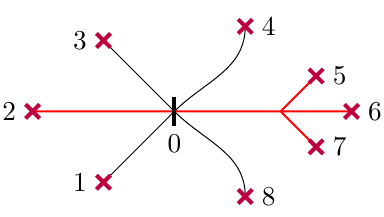
Figure 5 . Schematic example of a spectral network for instanton calculus. Here we have not depicted all the WKB lines, only those that (cid:13)ow to point 0 are shown, they are terminated at 0. We expect that WKB lines starting from branching points 1, 3, 4, 8 do not contribute as they are not symmetric with respect to re(cid:13)ection. WKB lines emanated from 2 and 6 are obviously symmetric with respect to re(cid:13)ection therefore they may contribute. Primary WKB lines emanated from 5 and 7 are not (cid:13)owing to 0, however they may create a secondary line in intersection that will (cid:13)ow to 0, and together they form a WKB subnetwork that is re(cid:13)ection-invariant and may contribute